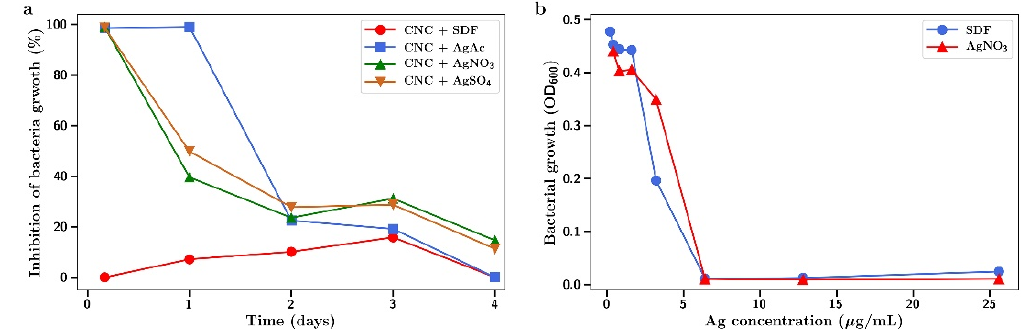
Figure 11. Inhibition of E. coli growth by ( a ) release media from incubation of SDF or silver salt crosslinked CNC at 4 h, 1, 2, 3, and 4 days; ( b ) E. coli growth as a function of silver concentration using SDF or silver nitrate in solution.